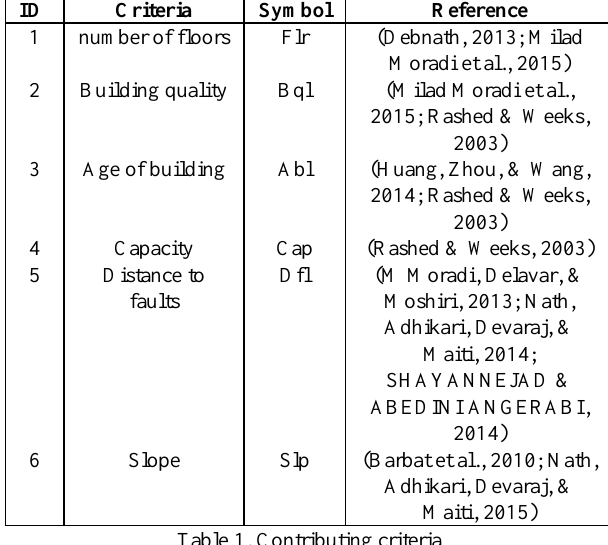
Table 1. Contributing criteria